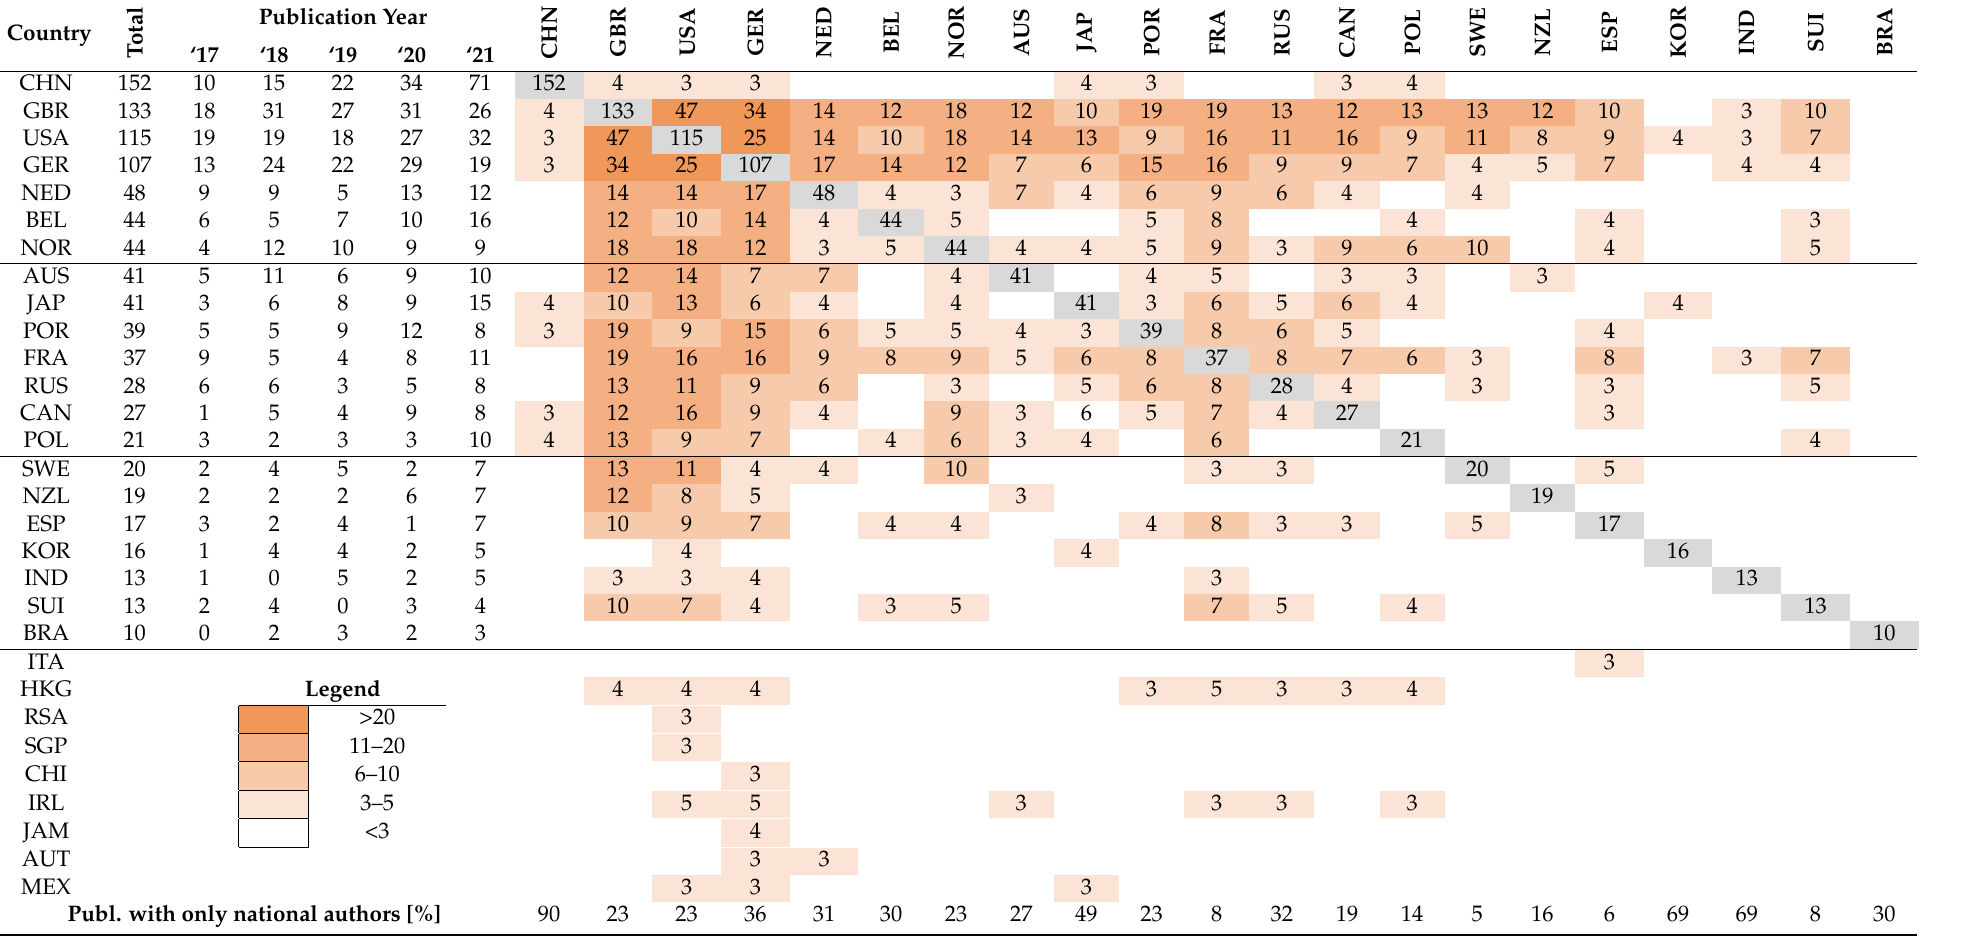
Table 4. Publications by country and extent of bilateral cooperation (2017–2021). Only countries with at least 10 publications are included, along with all respective pairwise (bilateral) intersections representing at least 3